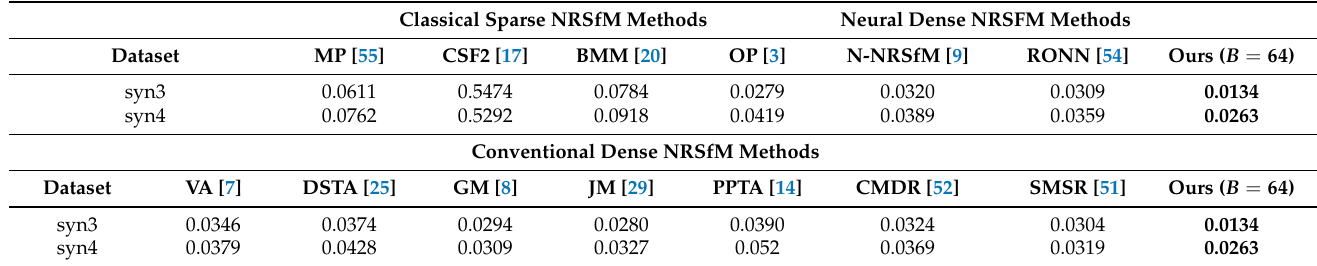
Table 4. e 3 D on the synthetic face sequences (syn3 and syn4).